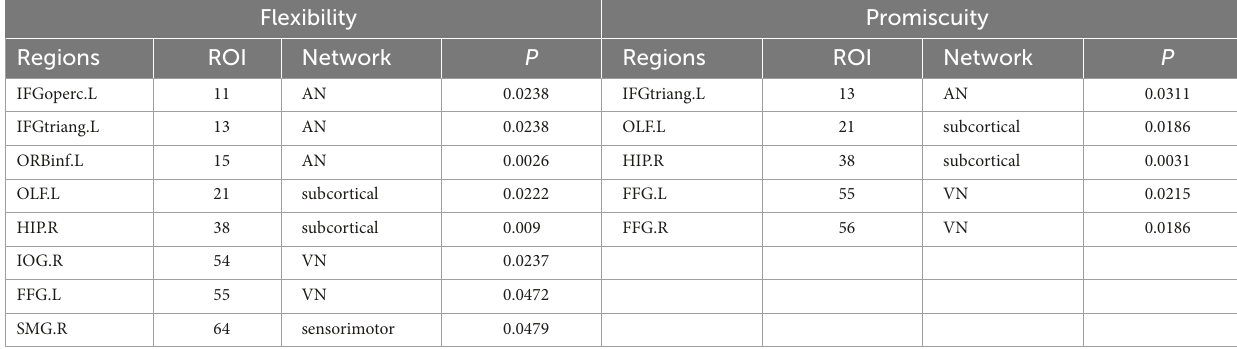
TABLE 3 Brain regions showing significant differences in flexibility and promiscuity. Flexibility Regions ROI IFGoperc.L